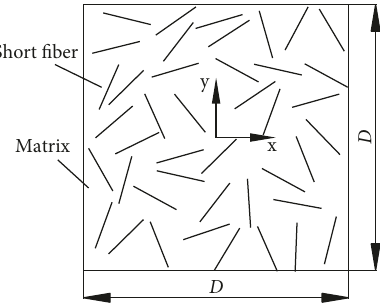
Figure 2: FE model of a short-fiber-reinforced composite, square shape with size D × D